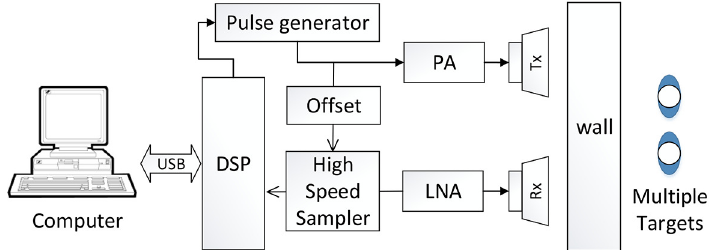
Figure 1. Block diagram of the single-input single-output (SISO) ultra-wideband (UWB) radar